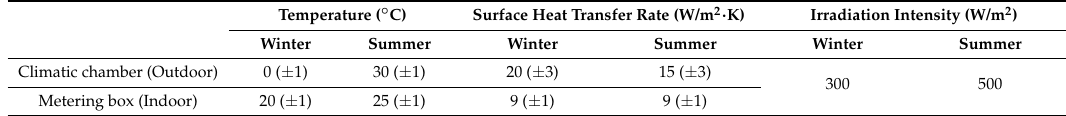
Table 1. Testing conditions for the Climatic chamber and the Metering